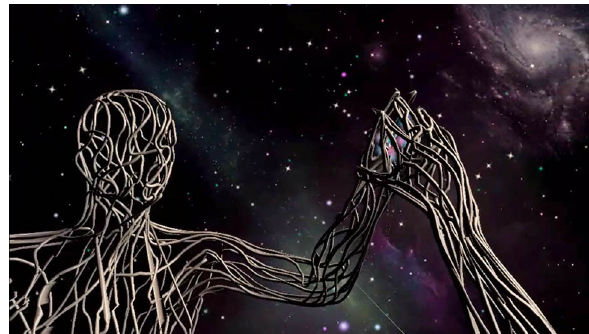
Figure 7: Screenshot of void VMSE taken from Oculus Quest.